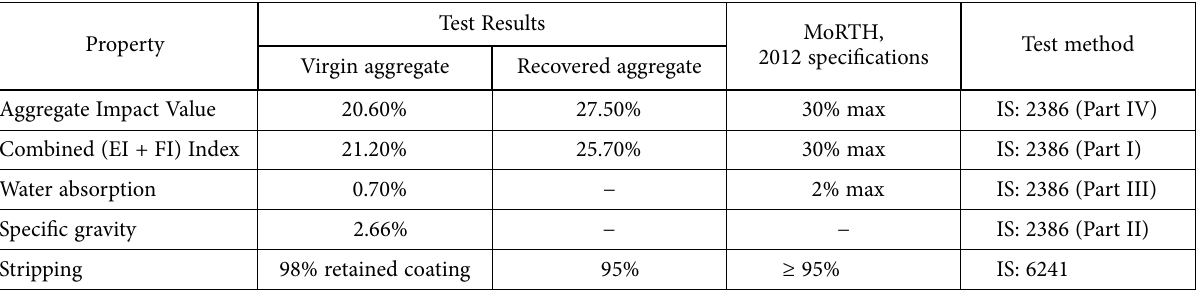
Table 1. Physical properties of